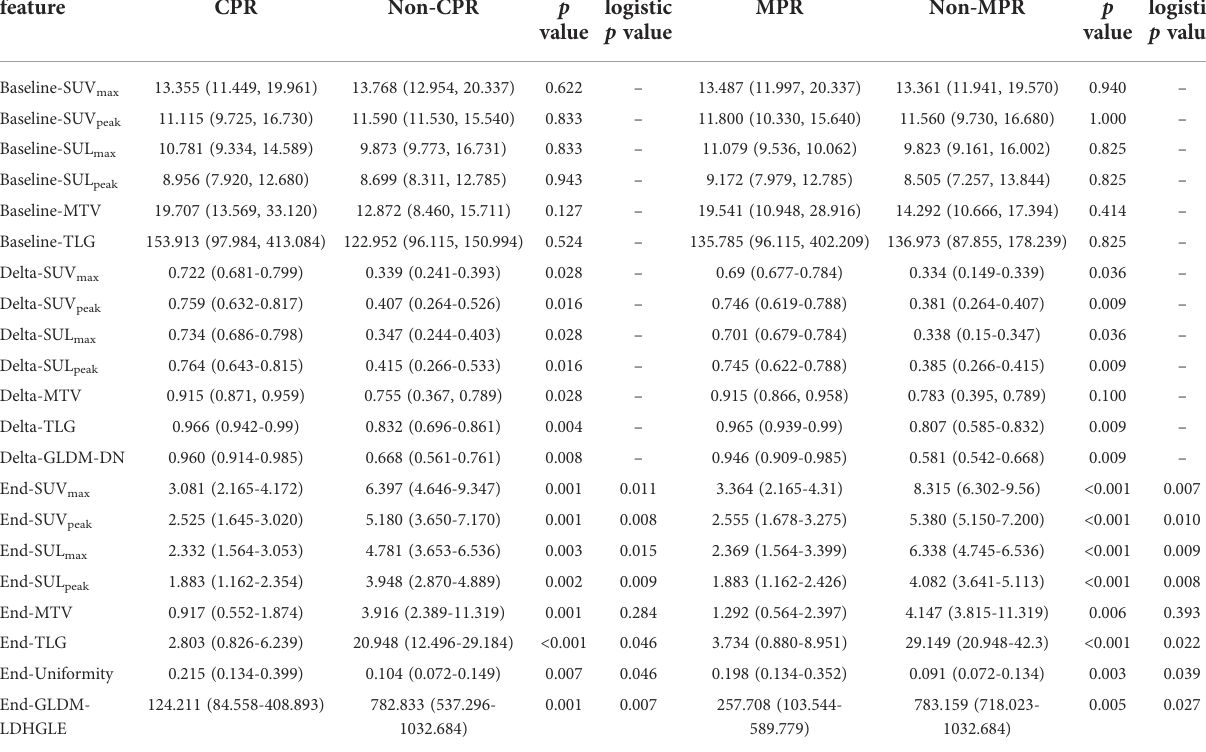
TABLE 3 The distributions of selected baseline, delta, and preoperative PET features and the univariate logistic regression results for preoperative PET features.